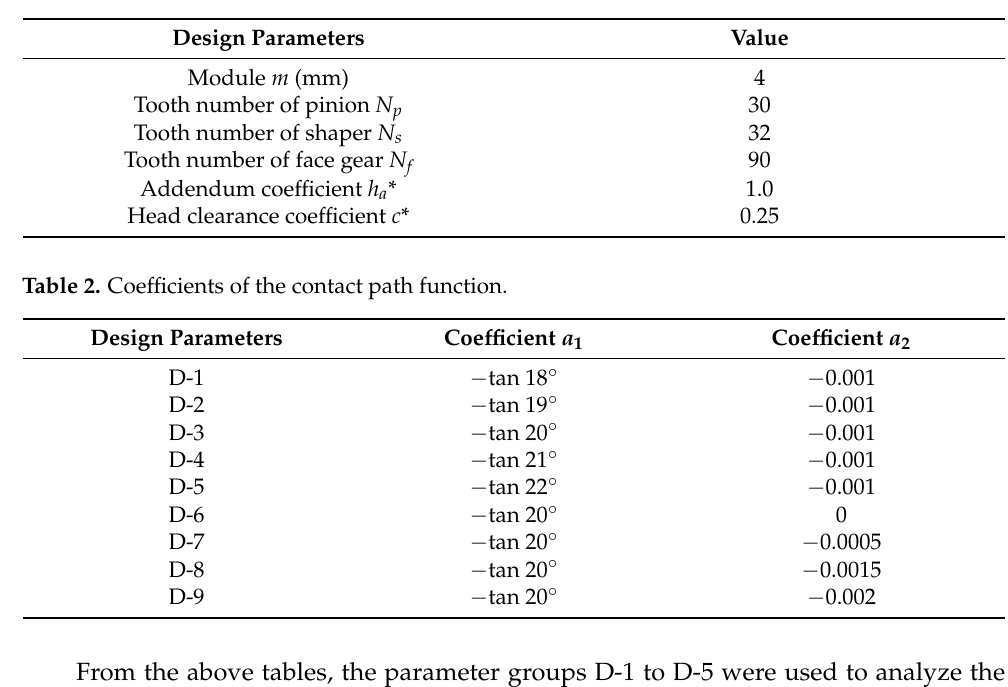
Table 1. The basic design parameters of the face gear drive.